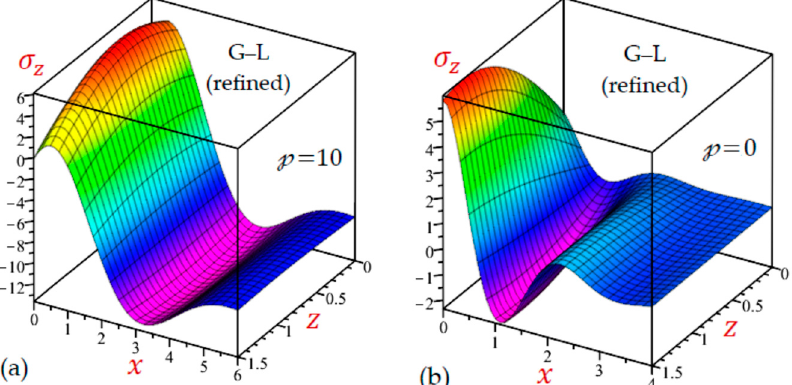
Figure 22. 3D distributions of the transverse normal stress σ z of the rotating half-space: ( a ) with initial pressure ( 𝓅 = 10 ); ( b ) without initial pressure ( 𝓅 = 0 ) using the refined L–S generalized the-